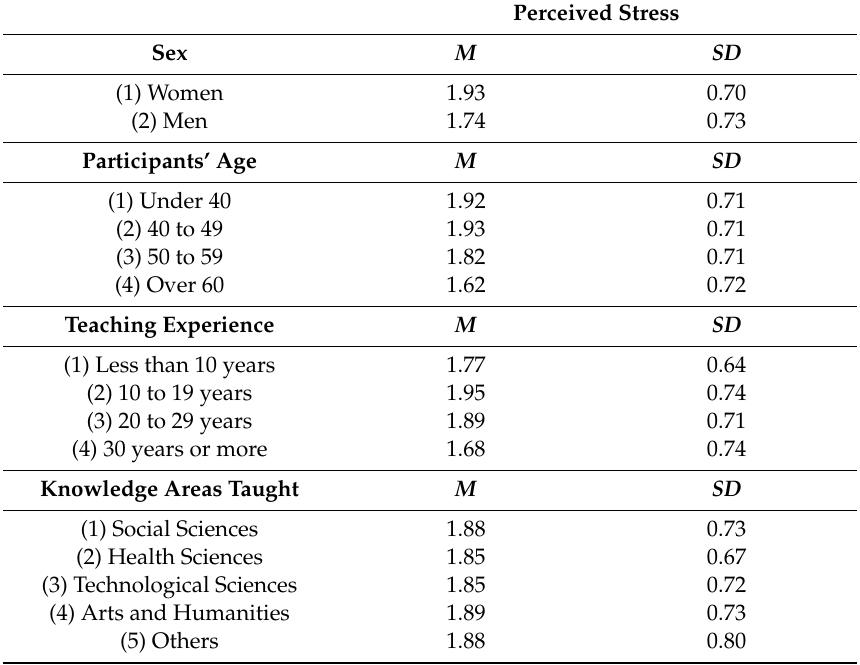
Table 2. Descriptive statistics in Perceived Stress depending on sex, age, teaching experience and knowledge areas